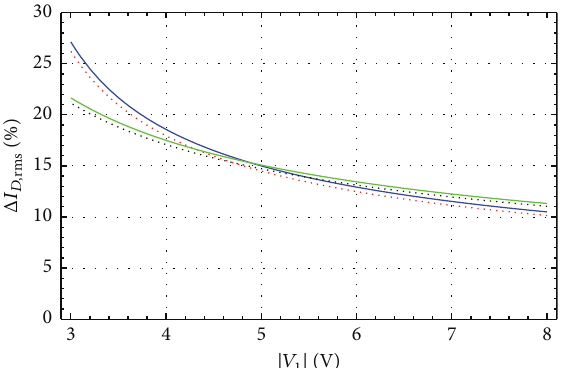
Figure 3: Triode and saturation regions N-type FGMOSFET based comparative plots of Δ𝐼 𝐷, rms ,𝑀 and Δ𝐼 𝐷, rms , SPICE against |𝑉 1 | where | = 0. |𝑉 2